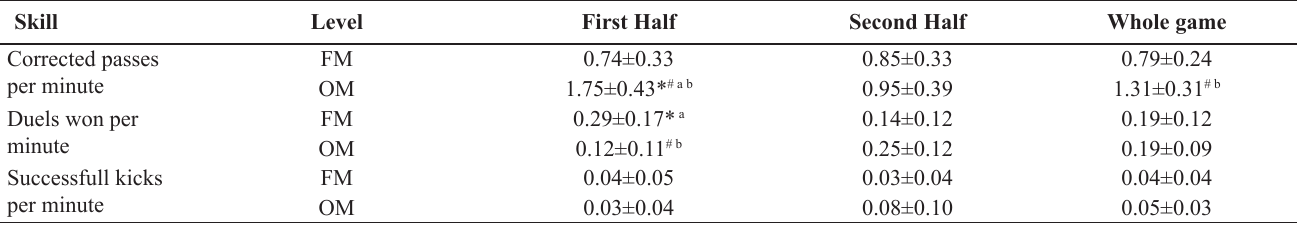
Table 5. Frequency of successful execution of the scout variables of technical skills during the official match (OM) and pre-season friendly match (FM), normalized by time on the court. Results are presented in mean ± standard